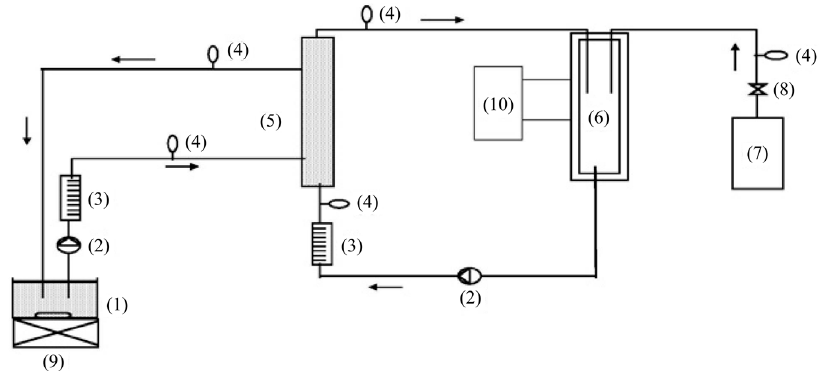
Figure 13. Schematic diagram of the photocatalysis-dialysis system. (1) feed tank; (2) circulation pump; (3) flow meter; (4) pressure gauge; (5) membrane module; (6) photoreactor; (7) oxygen cylinder; (8) blocking valve; (9) magnetic stirrer and (10) cooling device. Adapted with permission from [90], Copyright Elsevier, 2007.